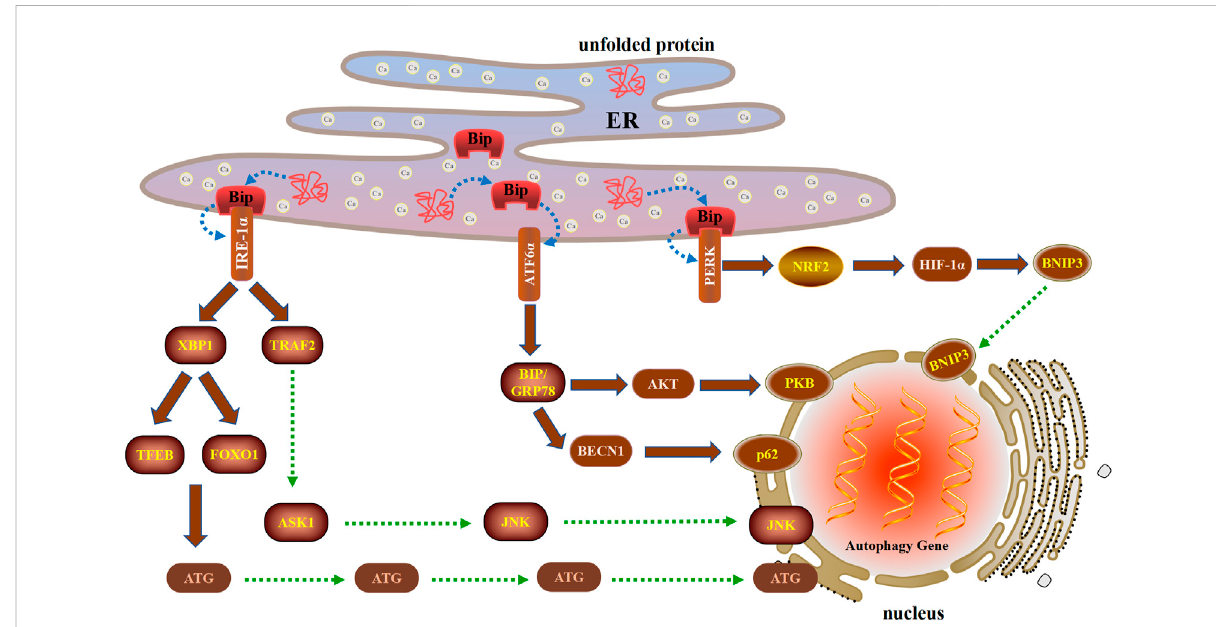
FIGURE 2 Three unique ways in whichthe UPR regulates autophagy during ERS after cell injury. The UPR is initiated by three ER transmembrane proteins: IRE1 α , PERK, and ATF6 α . IRE1 α can induce autophagy by activating XBP1 and TRAF2. When ERS triggers the UPR, PERK is activated and then induces autophagythroughthePERK-NRF2-HIF-1 α -BNIP3signalingpathway.ATF6 α inducesautophagybyupregulatingtheexpressionofBIPandinhibiting the AKT and BECN1 signaling